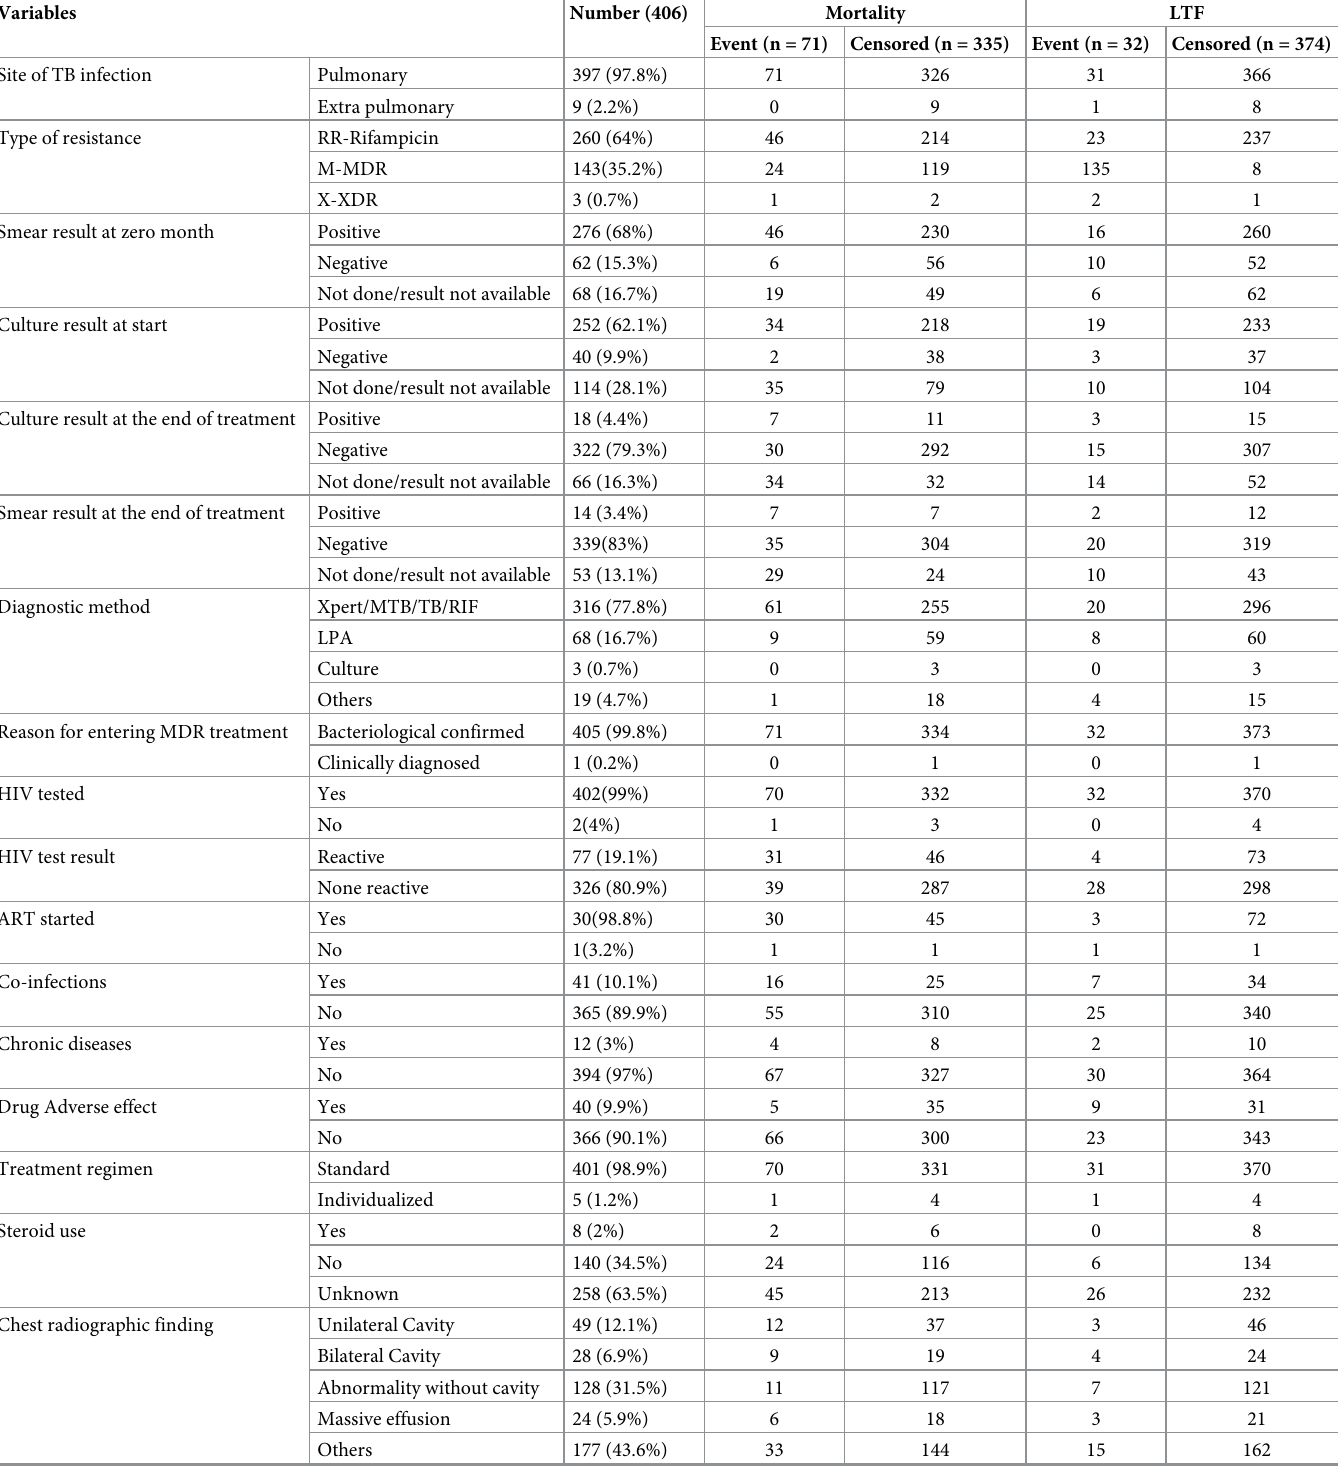
Table 2. Clinical characteristics of drug resistance tuberculosis infected patents in Oromia region, Ethiopia,